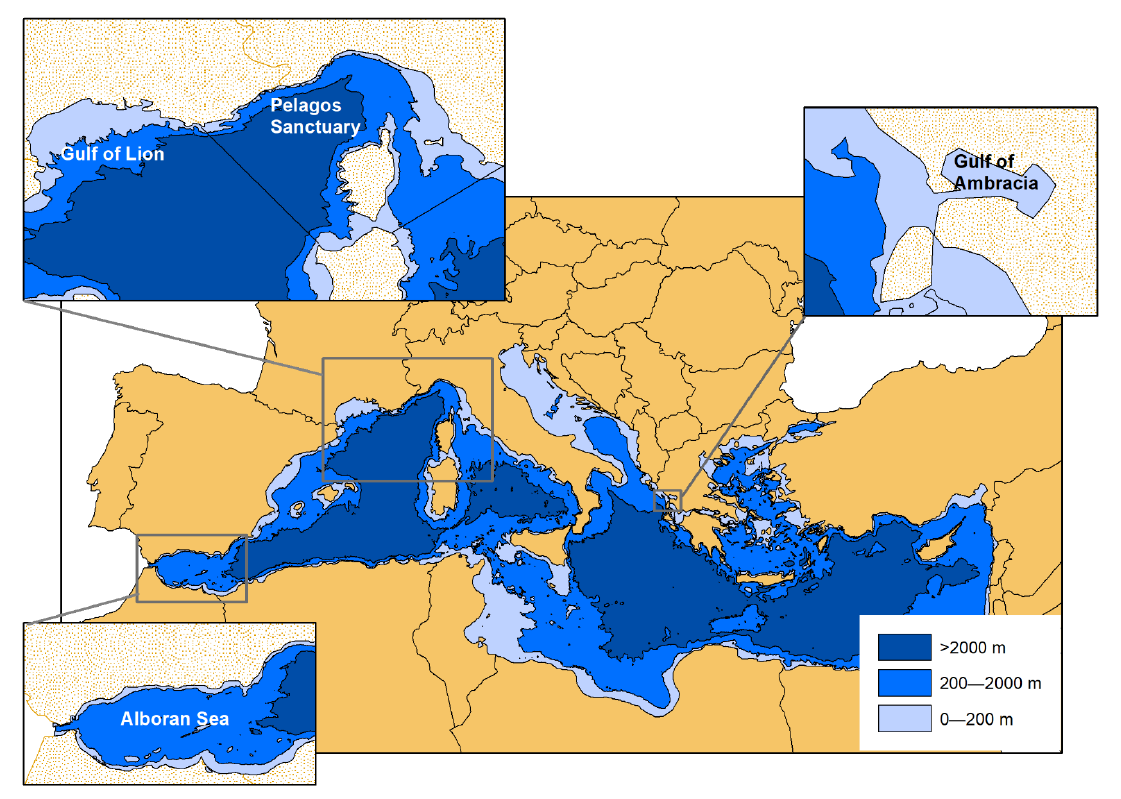
Figure 1. The geographical location of the study areas within the Mediterranean basin: Alboran Sea, Gulf of Lione, Pelagos Sanctuary, Gulf of Ambracia. Alboran